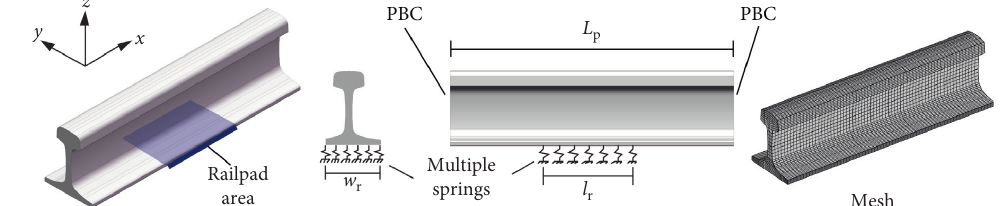
Figure 1: The periodic rail model.